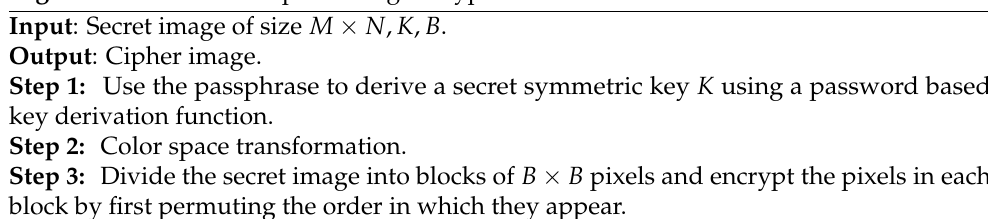
Algorithm 2 Thumbnail-preserving